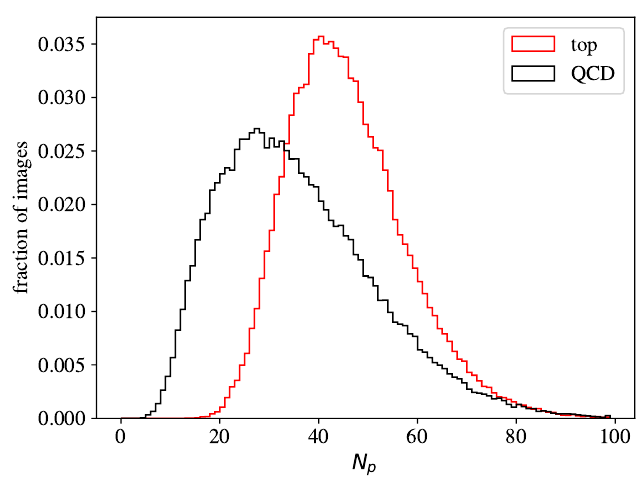
Figure 5 . Distribution of the QCD and top jet images in the number of non-zero pixels N p